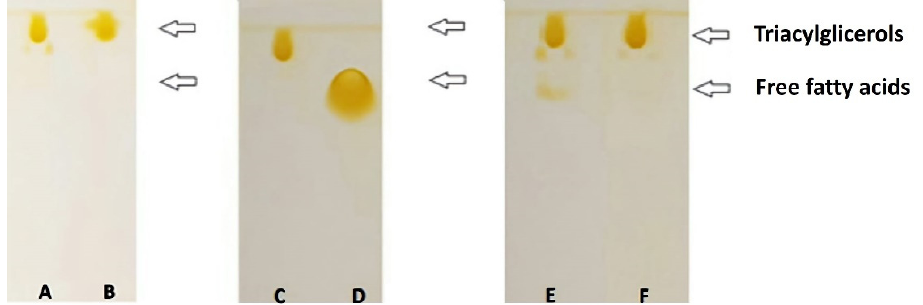
Figure 6. Thin-layer chromatography analysis: ( A ) non-purified CRSO, ( B , C ) purified CRSO, ( D ) n -3 LCPUFA, ( E ) optimized SAcyl non-purified, and ( F ) optimized SAcyl purified.